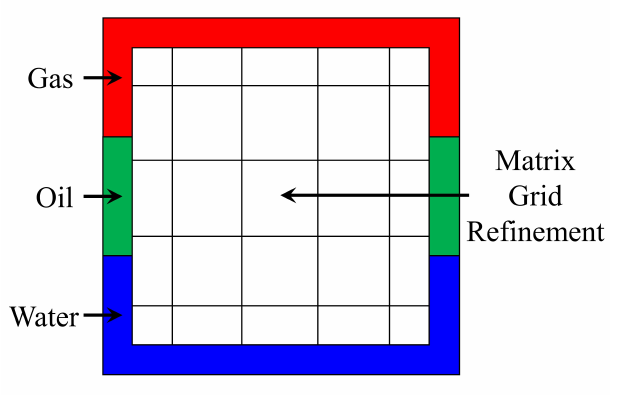
Figure 1. The subdomain approach suggested by Gilman and Kazemi to improve the gravity modelling which shown the matrix grid refinement in addition to the complete fluid segregation in the surrounding fractures when the capillary pressure is zero, after Gilman